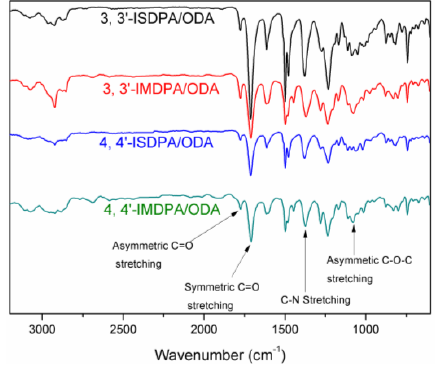
Figure 3. Representative FTIR spectra of isohexide-derived PEIs.